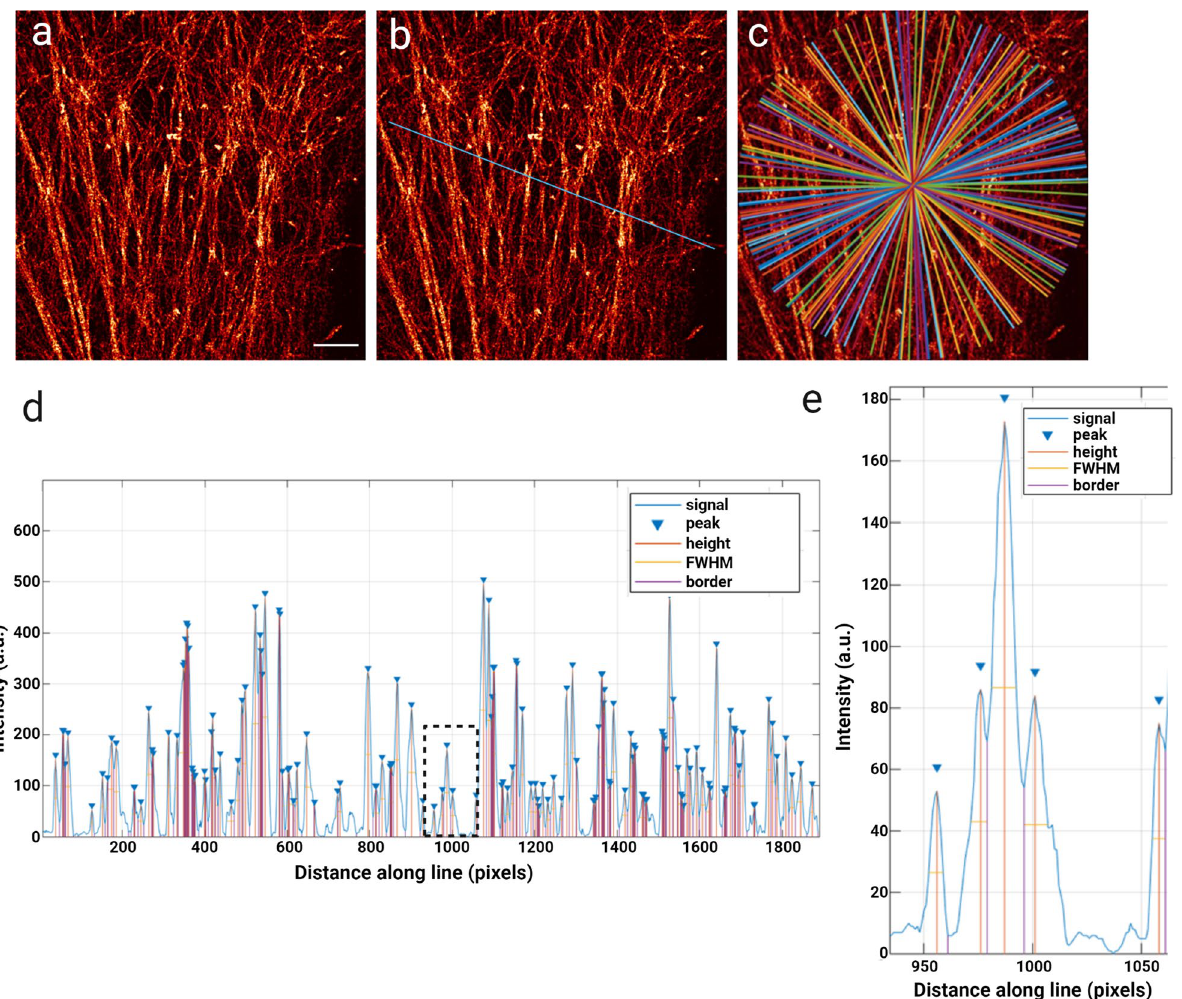
Figure 5. Example of analysis of expanded actin. ( a ) Example of 3D-SIM imaged expanded actin, with a scale bar of 10 μm (uncorrected for expansion factor). ( b ) Randomly generated line across the image for analysis, where intensity along this line is plotted in ( d ). ( c ) Example of the distribution of randomly generated analysed lines when repeated 100 times. ( d ) Normalised intensity line plot of fluorescence intensity (a.u.) vs distance along line for the line shown in ( b ), with peaks identified and height and width denoted as in the key. ( e ) Enlarged region of box in ( d ), showing identification of all distinguishable peaks above a manually set TIRF raw data and as quantified by SQUIRREL analysis. However, false sharpening and the collapsing of adjacent objects is a common issue in SR reconstructions, including in common single molecule localisation microscopy reconstruction algorithms 24 . Care should be taken when reconstructing super-resolution images and appropriate quality control checking performed. The application of SQUIRREL 19 here helped to identify regions of possible error in reconstructions. These were mostly observed in brighter, sharper regions of the reconstruction. However, it is important to note that the error maps are only internally relative; RSP values give a more inter-experiment and inter-technique comparable value, and in our experiments RSP values were consistently high. The meshwork analysis developed here performs well on SRRF data, and on data simulated to represent the binning and pixel size of SRRF data. The comparison of simulated versus ground truth data also highlighted that the analysis can underestimate some areas by over segmenting as well as missing smaller regions that sit below the resolution limit. This is, however, an issue inherent to any resolution limited image, and by filtering out very small corrals (i.e. those below the resolution limit) from further analysis. With this caveat in mind, the analysis performed well, identifying similar regions, which were also similar in size, between our simulated and ground truth data. To further test the analysis, and to see if it could detect subtle changes in the actin network, we treated cells with the actin disruptor cytochalasin D. From our analysis, the effect of cytochalasin D on the samples was as predicted—a visible disruption of normal cortical actin structure, with the persistence of some, especially thicker, filaments. Cytochalasin D acts by binding the barbed end of actin filaments, inhibiting polymerisation and dissociation from this end. Typically, cytochalasin D induces the formation of denser focal accumulations of actin, likely by interrupting normal anchoring of filaments by capping proteins 25 . As such, normal membrane associations should be severely disrupted, as indicated by our data. The accurate representation of cytochalasin